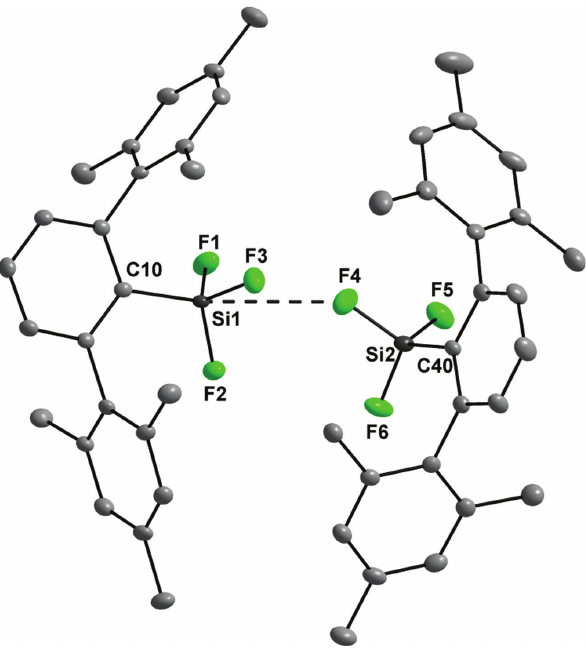
showing 30% probability ellipsoids and the crystallographic num- bering